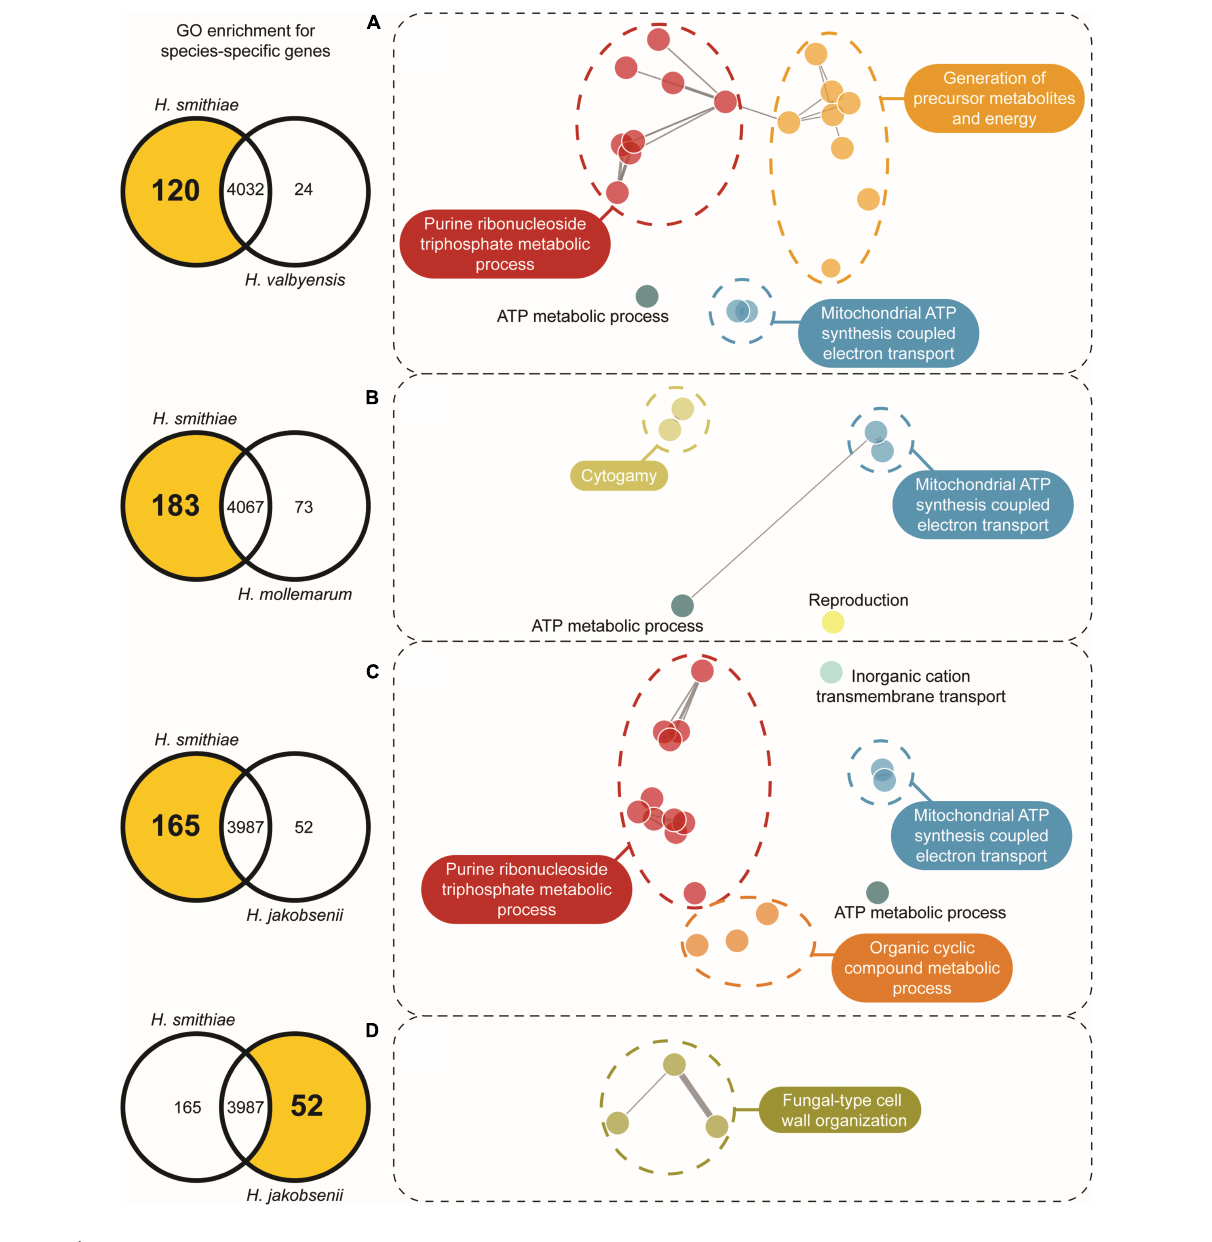
FIGURE 4 | Gene ontology (GO) network based on enriched species-specific GO terms for biologic processes. The selected number of genes is indicated on the left side in the Venn diagram for each species comparison. For each highlighted zone of the Venn diagram in (A–D) , the GO networks were constructed using REViGO with clustering based on shared ontology groups, indicated by their unique